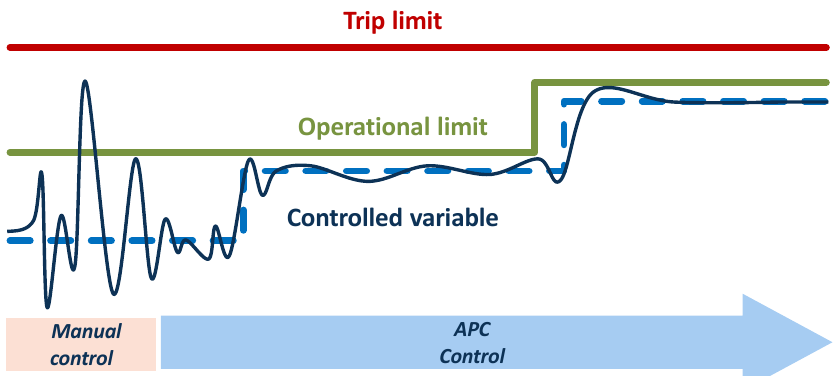
Figure 5. Temperature – time profile for analysis of structure formation at different cooling rates. The final, red-coloured heating segment served for analysis of the fraction of crystals in the prior cooling step.